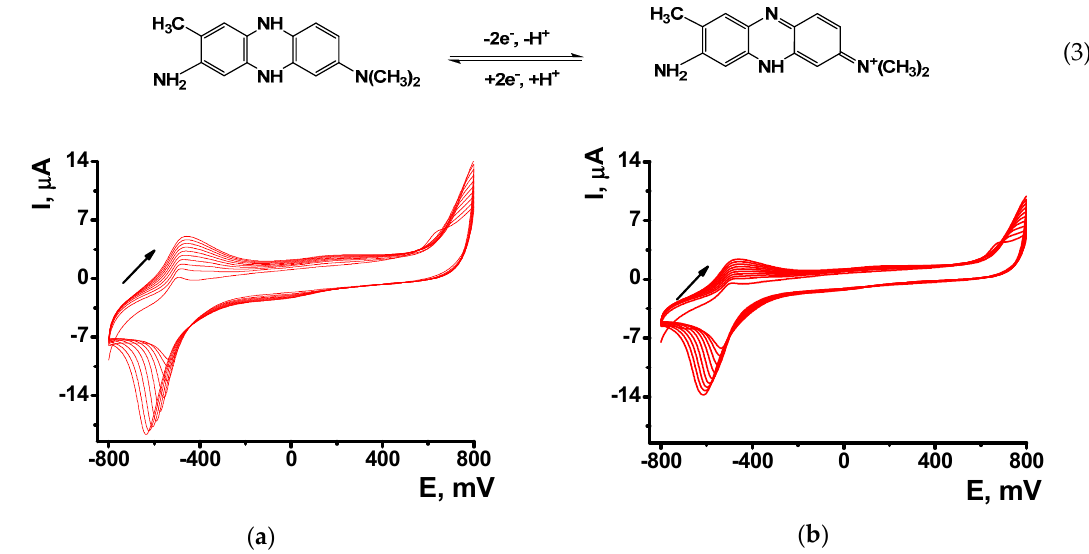
Figure 1. NR electropolymerization by multiple cycling of the potential in 0.025 M phosphate buffer + 0.1 M NaNO 3 (pH 6.0) containing 0.4 mM NR ( a ) and 0.4 mM NR + 0.2 mg/mL DNA ( b ). Scan rate was 50 mV/s. Arrow shows the direction of the potential scanning.